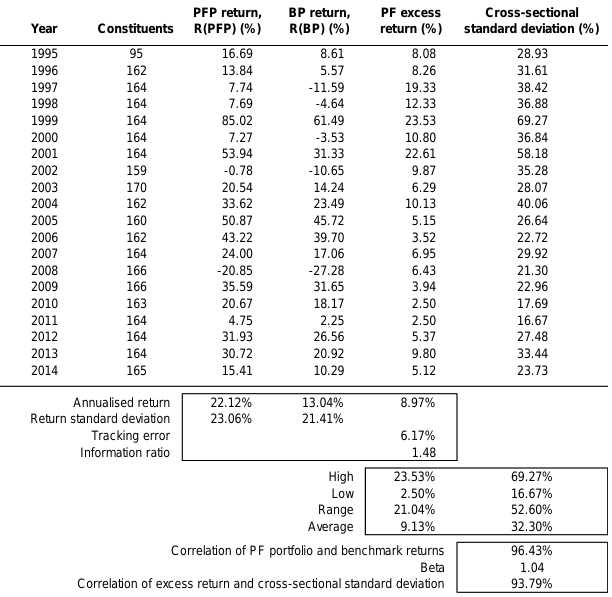
Table 1: All Share segment benchmark and PF portfolio results